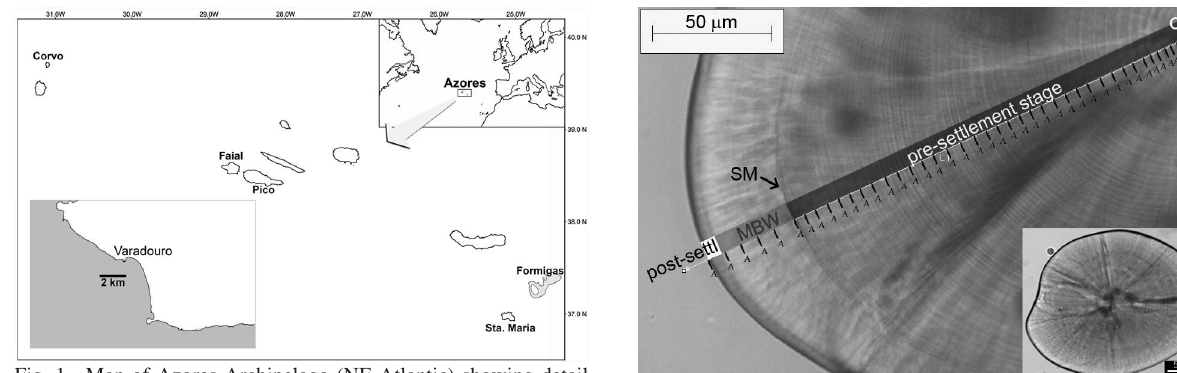
Fig. 1.- Map of Azores Archipelago (NE Atlantic) showing detail for Faial island and location of Varadouro. Fig. 2. –Sagitta from Coris julis recruits collected in the Azores. Black tick marks indicate daily increments. MBW = Metamorphic band width and post-settl = Otolith material deposited after emer- gence. SM indicates the otolith settlement